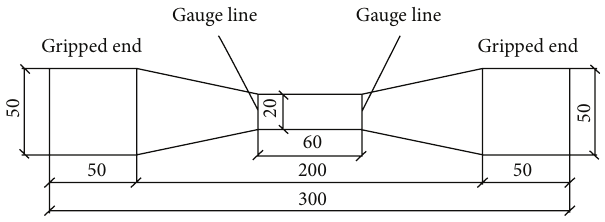
Figure 1: Dimensions of dumbbell